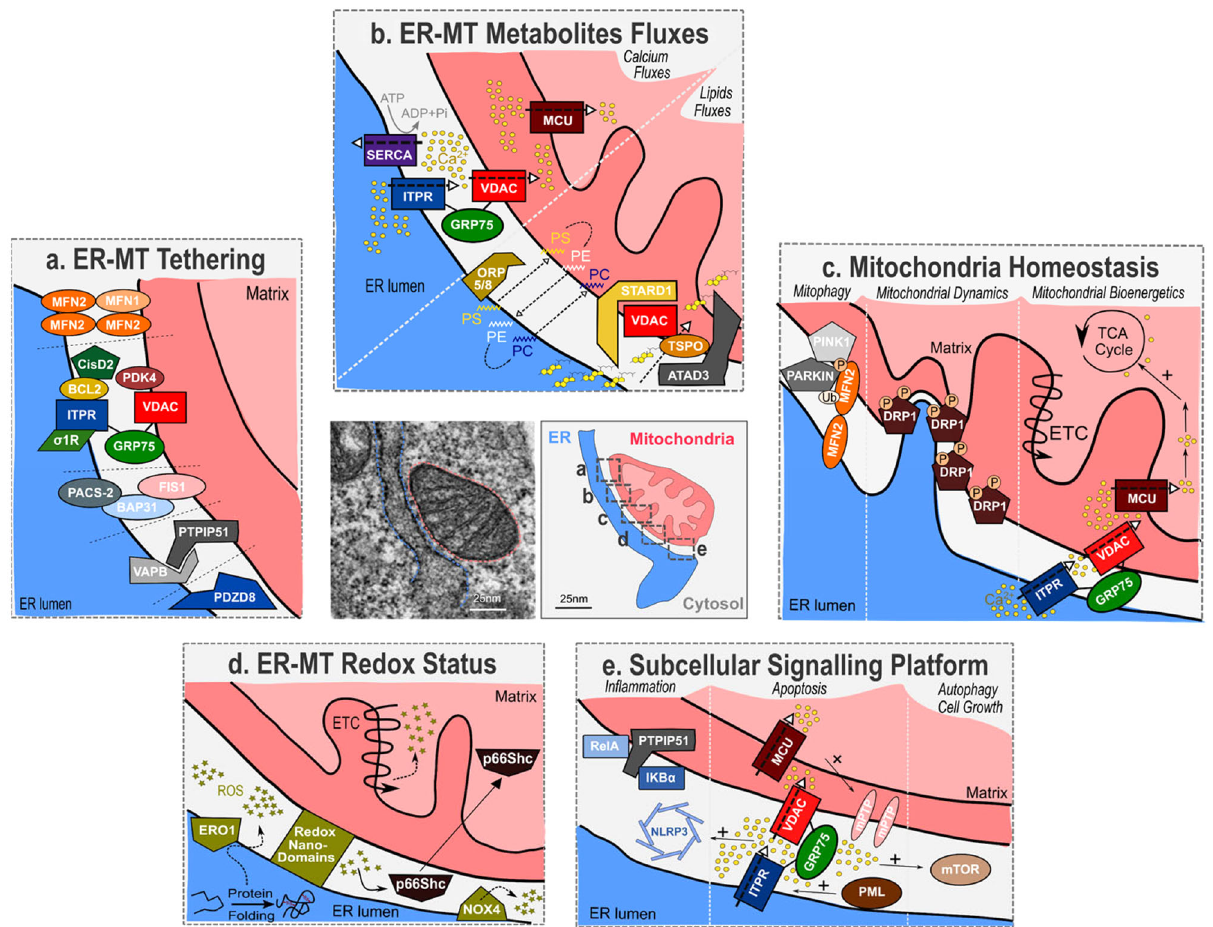
Fig. 1 Key components and associated functions of mitochondria – ER contacts. Electron micrographs of MERCs, ER in blue and mitochondrion in red. a Multiple tethers allow the establishment of MERCs and include MFN1/MFN2 homodimers and heterodimers, ITPR-GRP75-VDAC complex, FIS1/BAP31, VAPB/PTPIP51 and PDZD8. Some MERC-associated proteins, including CisD2, PACS-2, PDK4 and SIGMAR1, interact with tethers to modulate MERCs. b MERCs are at the crossroad of calcium and lipids exchanges between ER and mitochondria. Dynamics of calcium fl uxes within MERCs where ITPR, VDAC and MCU calcium channels insure transfer from ER to mitochondria and SERCA pump from cytosol to ER. Phospholipids (PS phosphatidylserine, PE phosphatidylethanolamine, PC phosphatidylcholine) are transferred trough MERCs, notably by ORP5/8 proteins, and cholesterol binds to STARD1/ VDAC1/TSPO complex before being imported into the mitochondria. c MERCs regulate mitochondrial homeostasis notably through mitophagy, mitochondrial fi ssion and mitochondrial bioenergetics. PINK1 phosphorylates MFN2, which recruits PARKIN at MERCs. PARKIN ubiquitinates MFN2 to initiate mitophagy. ER wraps mitochondria in initiation sites of fi ssion and recruits DRP1. Calcium cation transfers from ER to mitochondria fuel some calcium-activated TCA cycle dehydrogenases and transporters to promote oxidative phosphorylation. d MERCs control redox status of ER and mitochondria. ERO1 is coupled to protein folding oxidation and generates ROS (H 2 O 2 ). Redox nanodomains are formed within MERCs interface. NAPDH oxidase NOX4 produces ROS, while p66Shc senses ROS before relocalizing to mitochondria. e MERCs act as subcellular signalling platforms. Members of the NF- κ B pathway, RelA and IK κ B α , interact with PTPIP51. ITPR-mediated calcium release allows high local concentration of calcium and could participate in the recruitment and activation of mTOR and NLRP3. Promyelocytic Leukemia protein (PML) is found in MERCs